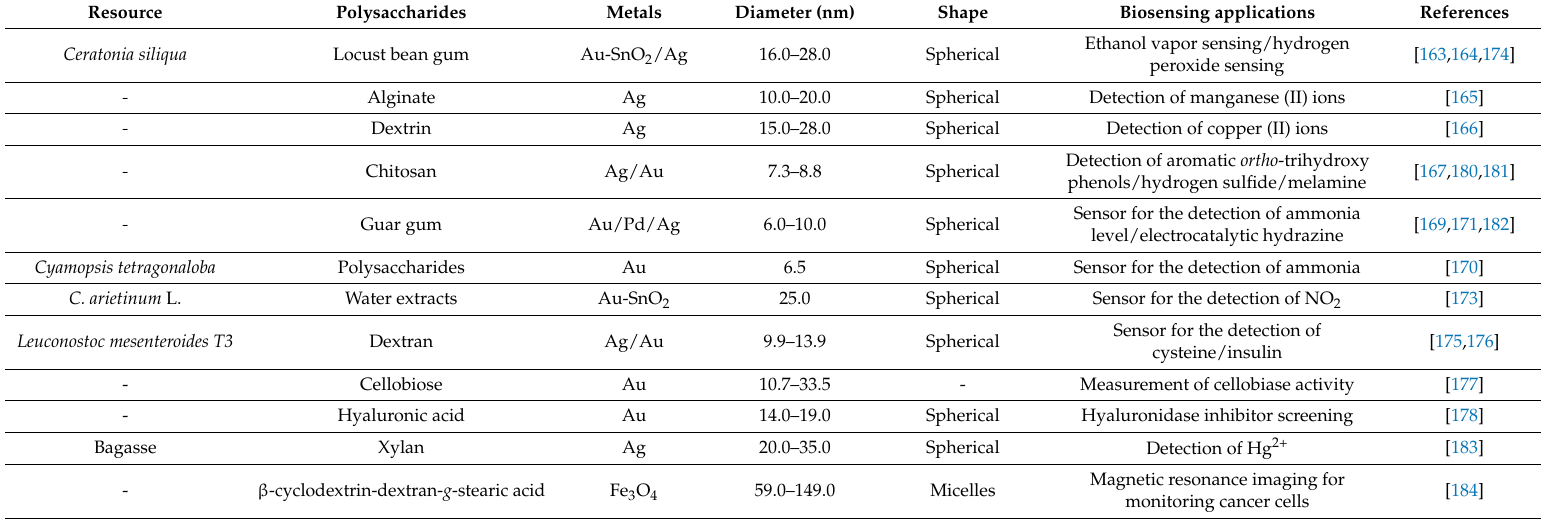
Table 4. Summary of literature data regarding the polysaccharide-based MNPs for